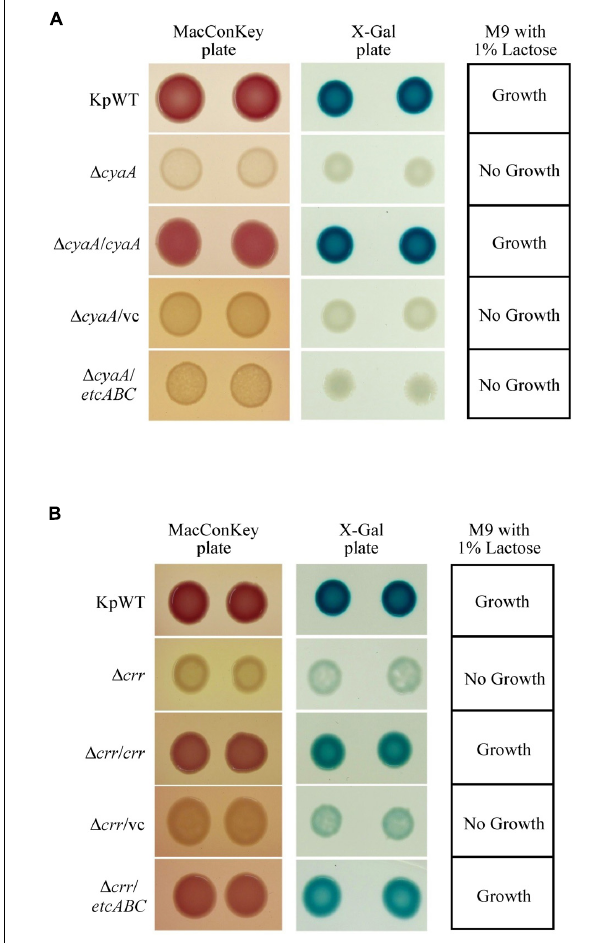
FIGURE 4 | Colony morphology of K. pneumoniae STU1 and its derivative strains on MacConkey agar (MacConkey plate) and LB agar containing X-gal (X-gal plate) and bacterial growth in M9 minimal medium containing 1% lactose as the sole carbon source (M9 with 1% lactose) after overnight culture. KpWT: wild-type. (A) The phenotype of cyaA mutant and its derivative strains. (cid:49) cyaA : cyaA mutant. (cid:49) cyaA/cyaA : complementation strain of the cyaA mutant carrying pBSK::Gm::cyaA. (cid:49) cyaA /vc: cyaA mutant carrying pBSK-Gm as the vector control. (cid:49) cyaA/etcABC : cyaA mutant carrying